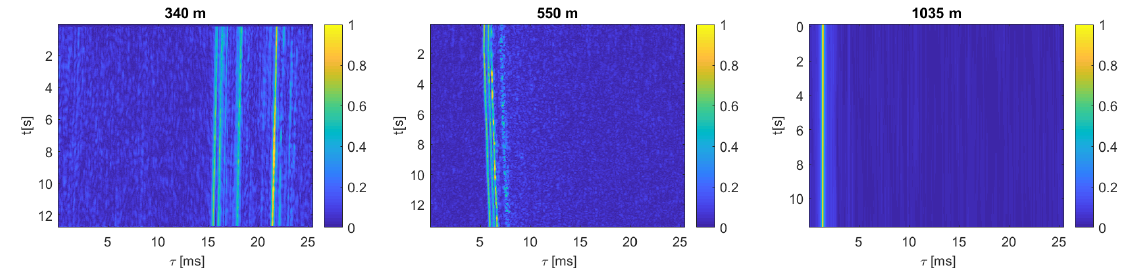
Figure 3. The module of exemplary time-varying impulse responses of the inland water channel.